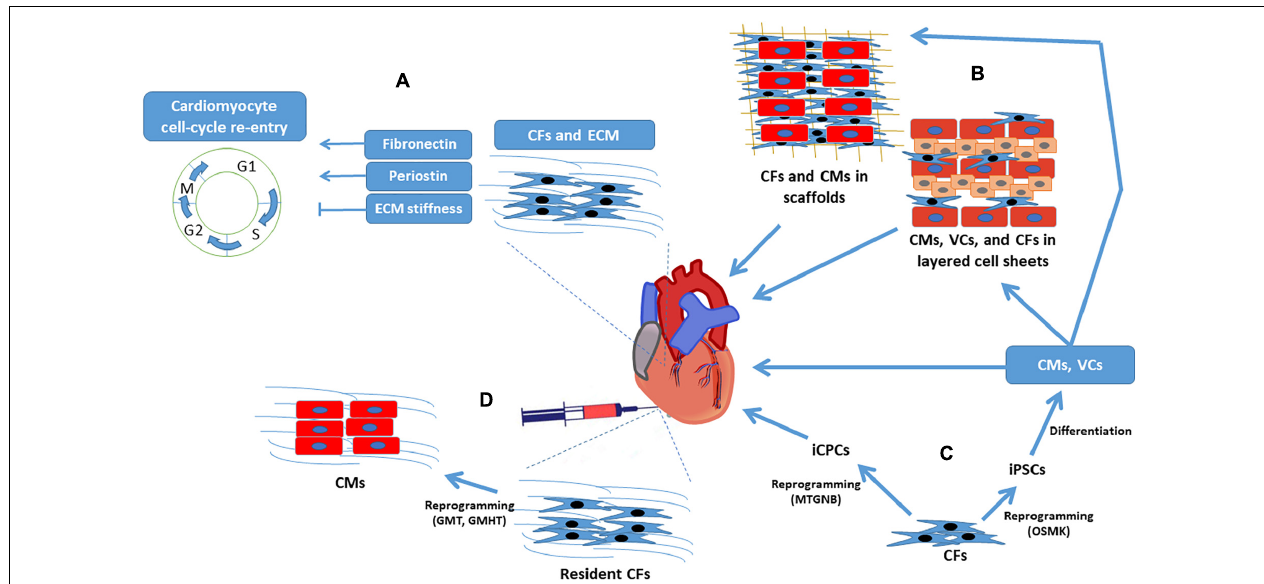
FIGURE 2 | Cardiac fibroblasts for regenerative myocardial therapy. Clockwise from top left: (A) CFs secrete cytokines that directly regulate cardiomyocyte cell-cycle activity, and the structural proteins produced by CFs influence cardiomyocyte proliferation by modulating ECM stiffness. (B) CFs have a supportive role in engineered myocardial tissues and (C) can be reprogrammed into iPSCs or iCPCs; iPSCs are differentiated into cardiomyocytes, endothelial cells, and smooth-muscle cells before administration to infarcted hearts or assembly into engineered myocardial tissues, whereas iCPCs spontaneously differentiate into cardiac cells after delivery to the heart. (D) CFs can also be reprogrammed directly into cardiomyocyte-like cells both in-vitro and in-vivo . CF, cardiac fibroblast; CM, cardiomyocyte; ECM, extracellular matrix; GHMT, Gata4, Hand, Mef2c, Tbx5; GMT, Gata4, Mef2c, Tbx5; iCPC, induced cardiac progenitor cell; iPSC, induced pluripotent stem cell; MTGNB, Mesp1, Tbx5, Gata4, Nkx2.5, Baf60c; OSMK, Oct4, Sox2, c-Myc, Klf4; VC, vascular